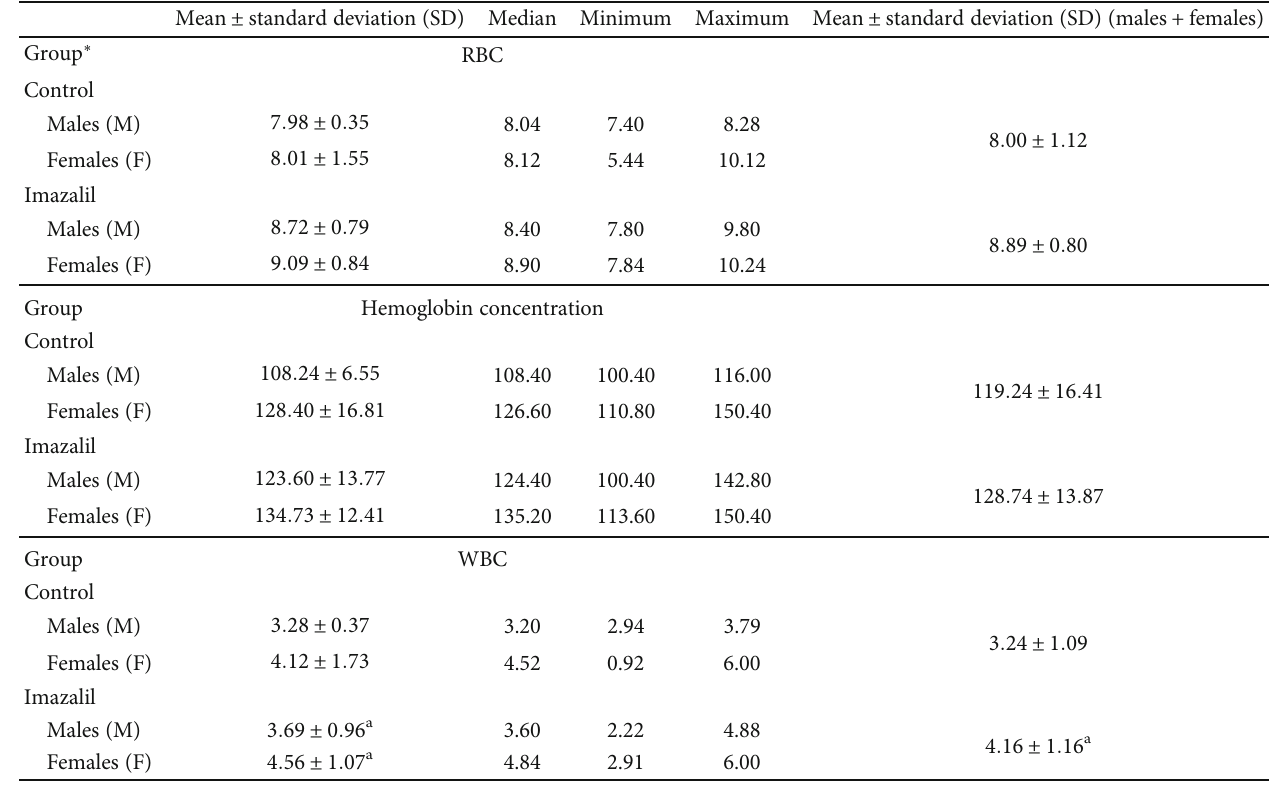
Table 4: Number of erythrocytes (RBC), white blood cells (WBC), and hemoglobin concentration in Swiss albino mice after 28 days of treatment with imazalil expressed as mean standard deviation (SD), median, minimum, and maximum.